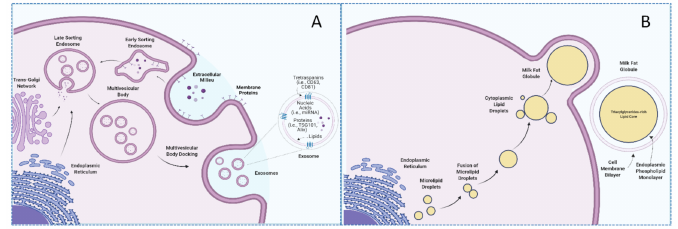
Figure 1. Biogenesis of milk exosomes and milk fat globules. ( A ), milk exosomes; ( B ), milk fat